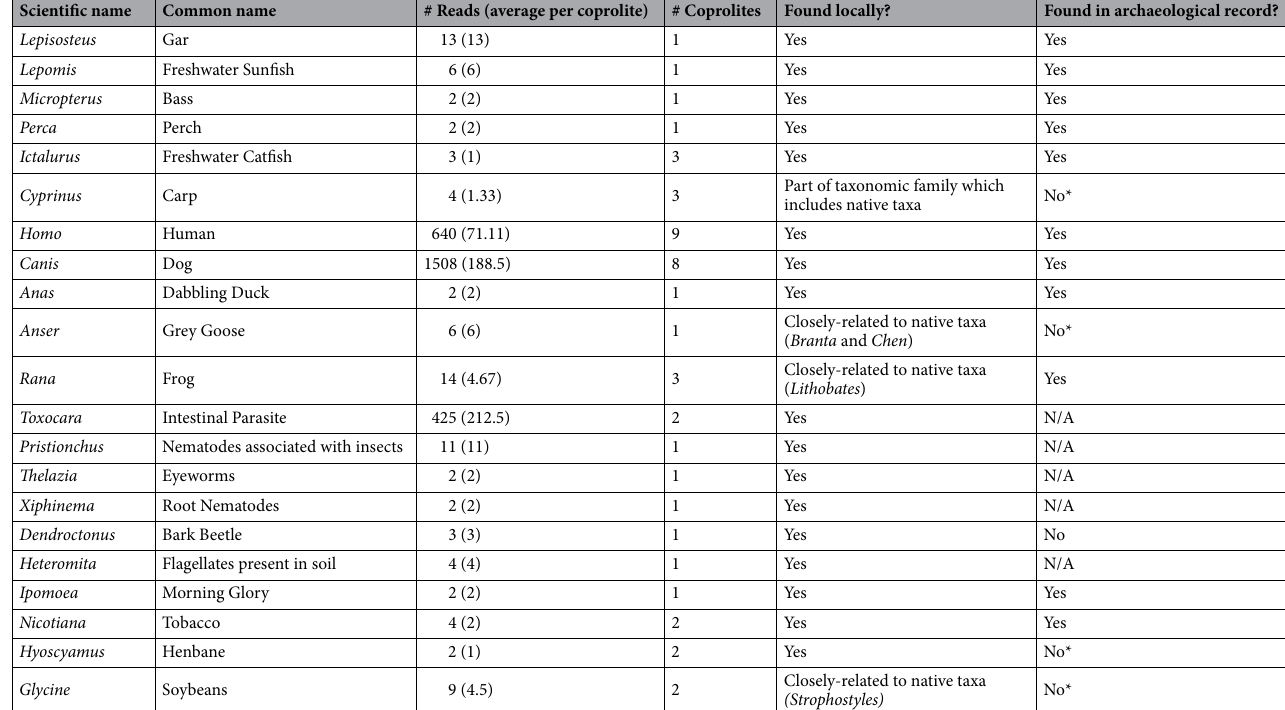
Table 1. A list of the taxa recovered from DNA sequencing of the coprolites. In the reads column, the average number of reads per coprolite that contained reads from that species is noted in parentheses. Counts of reads per coprolite can be found in Supplemental Table 4. * indicates that the genus identified in the database is not present in the archaeological record of the American Bottom, but another genus in the same family is present. N/A: Studies of parasites have not been conducted in American Bottom archaeological